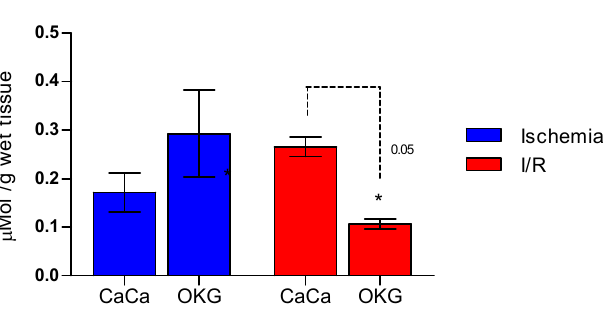
FIGURE 6 - Reduced glutathione levels (micromoles per gram of fresh tissue) in small intestine samples from CaCa and OKG-pretreated rats. Bars represent mean±SD of ischemia (blue bars) and reperfusion (red bars) groups at the end of the ischemia (30 min) and reperfusion (30 min). GSH levels in OKG treated rats are not different from CaCa-treated rats by Student´s t test.